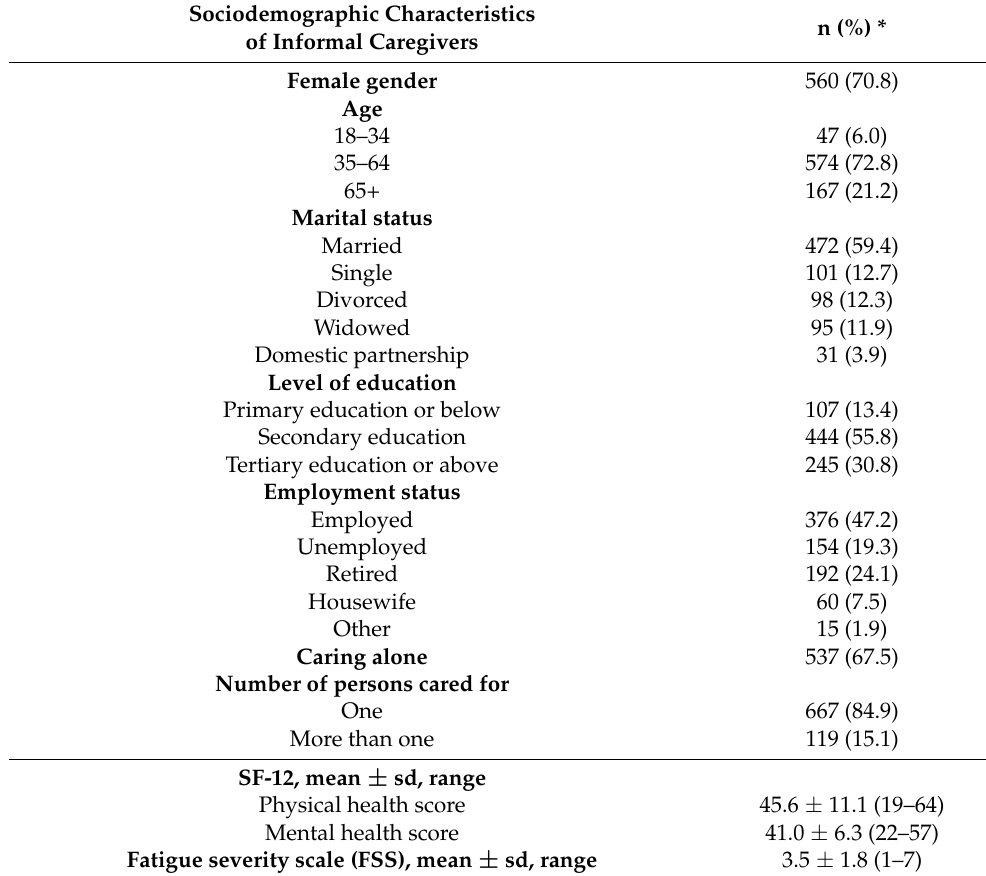
Table 1. Sociodemographic characteristics, SF-12, and fatigue severity scale (FSS) of informal